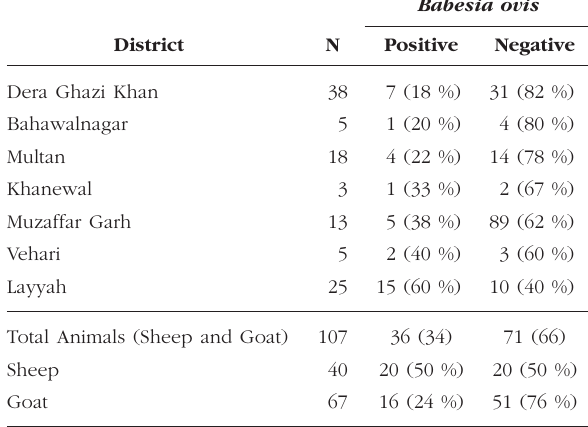
Table I. – Sampling sites along with the total number of samples collected (N) from each district. Prevalence of parasite is given in